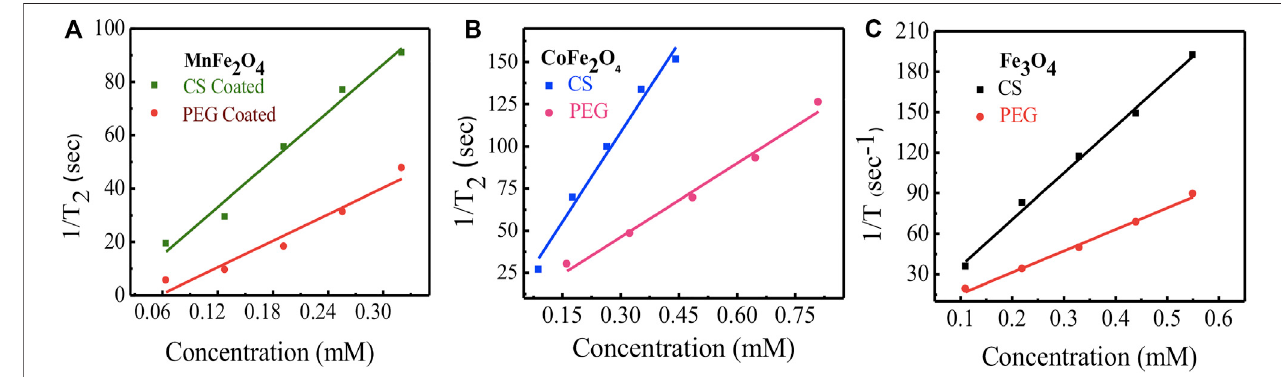
FIGURE 11 | NMR relaxivity pro fi les and concentration dependence of relaxation rate (1/T 2 (cid:2) R 2 ) of nanoparticles with coating agents chitosan and PEG for (A) MnFe